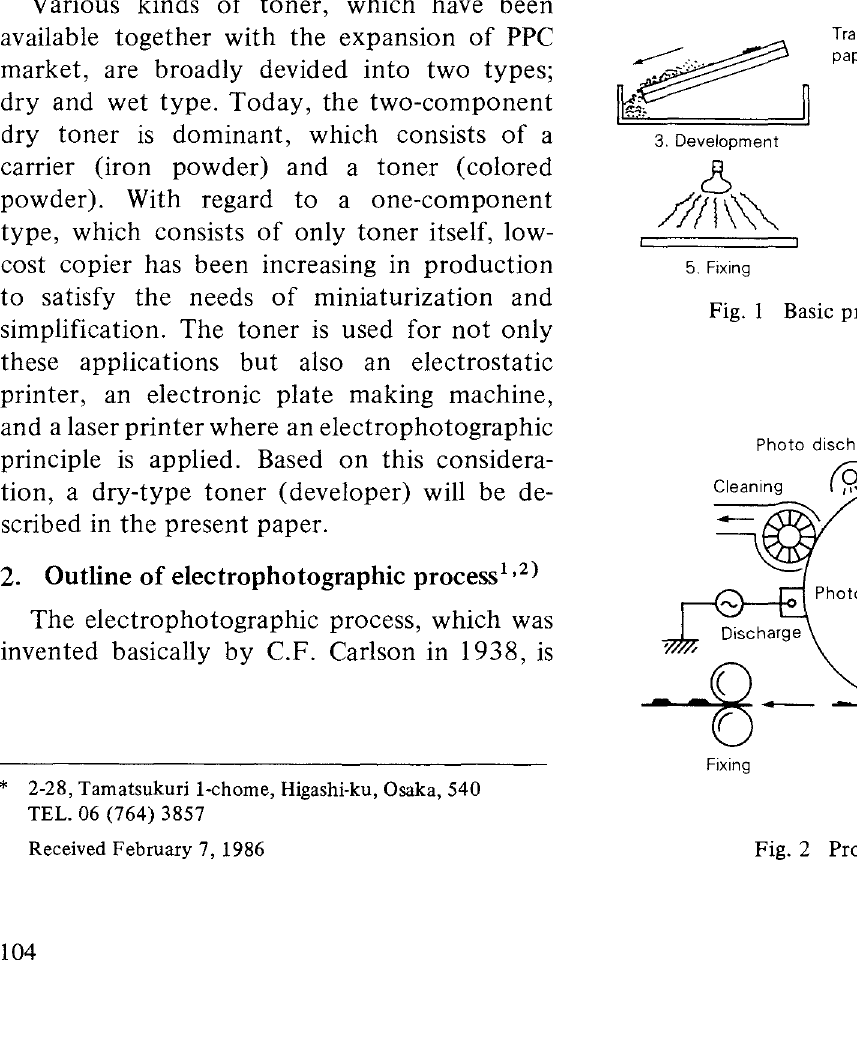
Fig. 2 Process of PPC